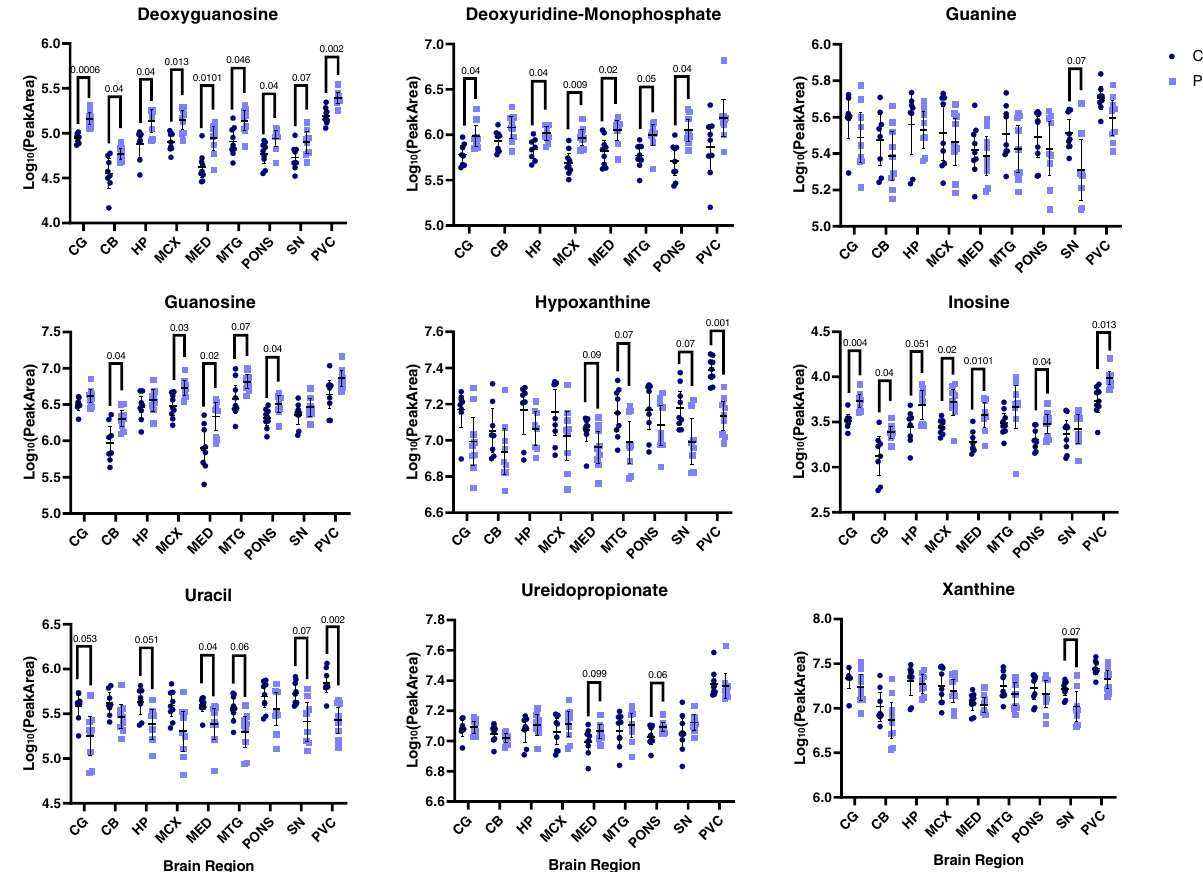
Fig. 4 Purine pathway metabolites in the PDD brain. Data shown are mean log 10 peak area data ±95% con fi dence intervals. C control, PDD Parkinson ’ s disease dementia. Q values are shown for signi fi cant discoveries determined by multiple t -tests corrected by 10% FDR. CB cerebellum, CG cingulate gyrus, HP hippocampus, MCX motor cortex, MED medulla oblongata, MTG middle temporal gyrus, PVC primary visual cortex, SN substantia